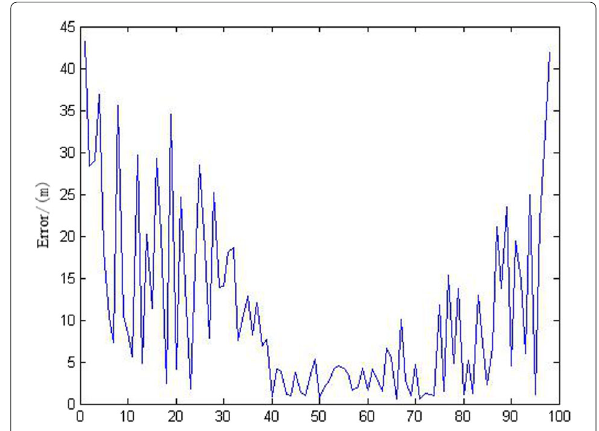
Fig. 7 Analysis of root mean square error